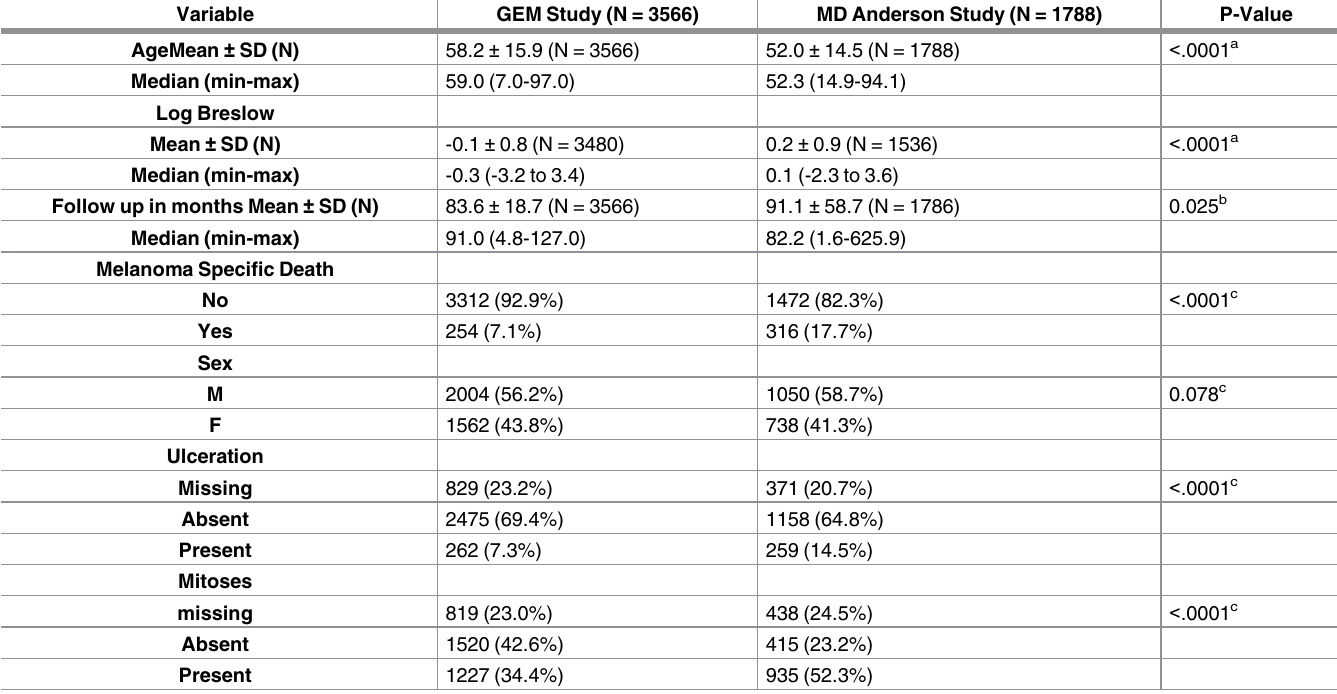
Table 1. Patient demographics and characteristics of the GEM and MD Anderson